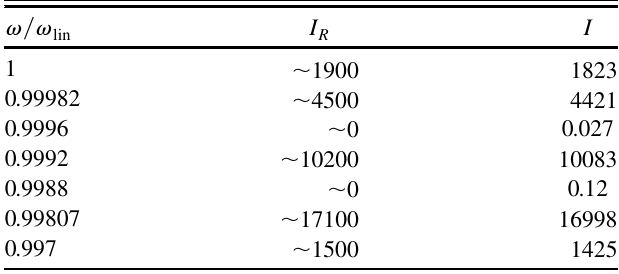
TABLE I. Comparison between the intensity I Fig. 5a (blue curve) of Ref. [24] and that calculated by our code I for some points, showing a good agreement.